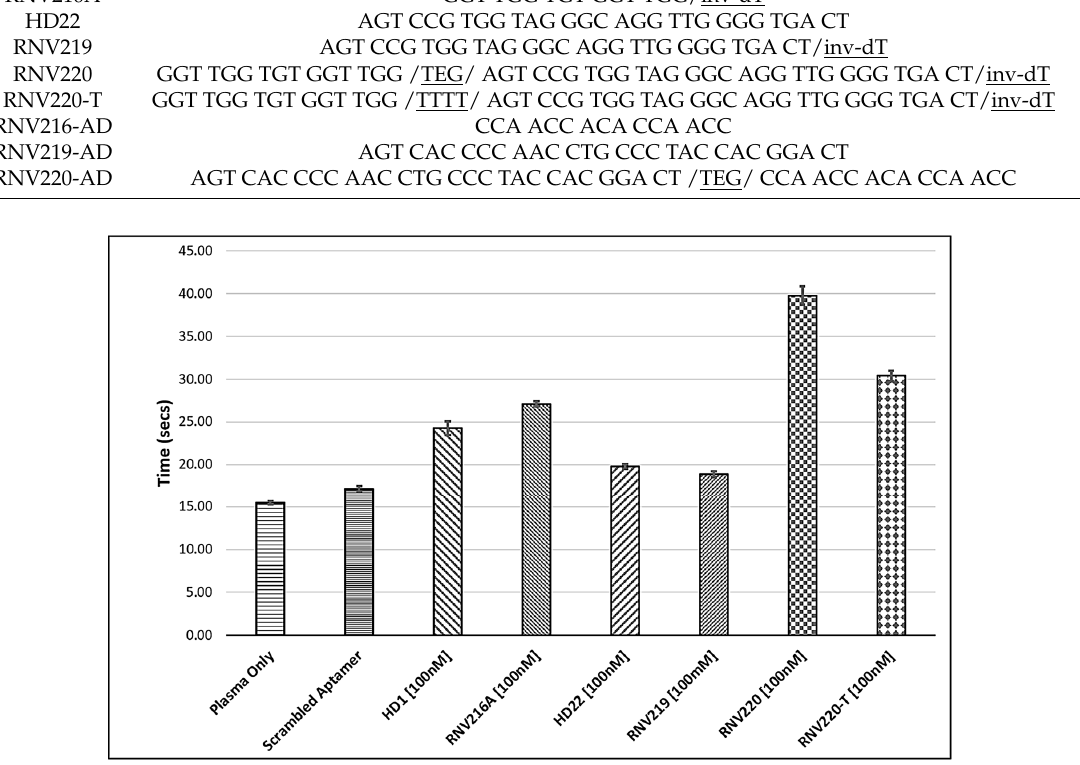
Figure 2. Thrombin clotting time (TCT) analysis of the aptamers RNV216A, RNV219, RNV220, and RNV220-T.